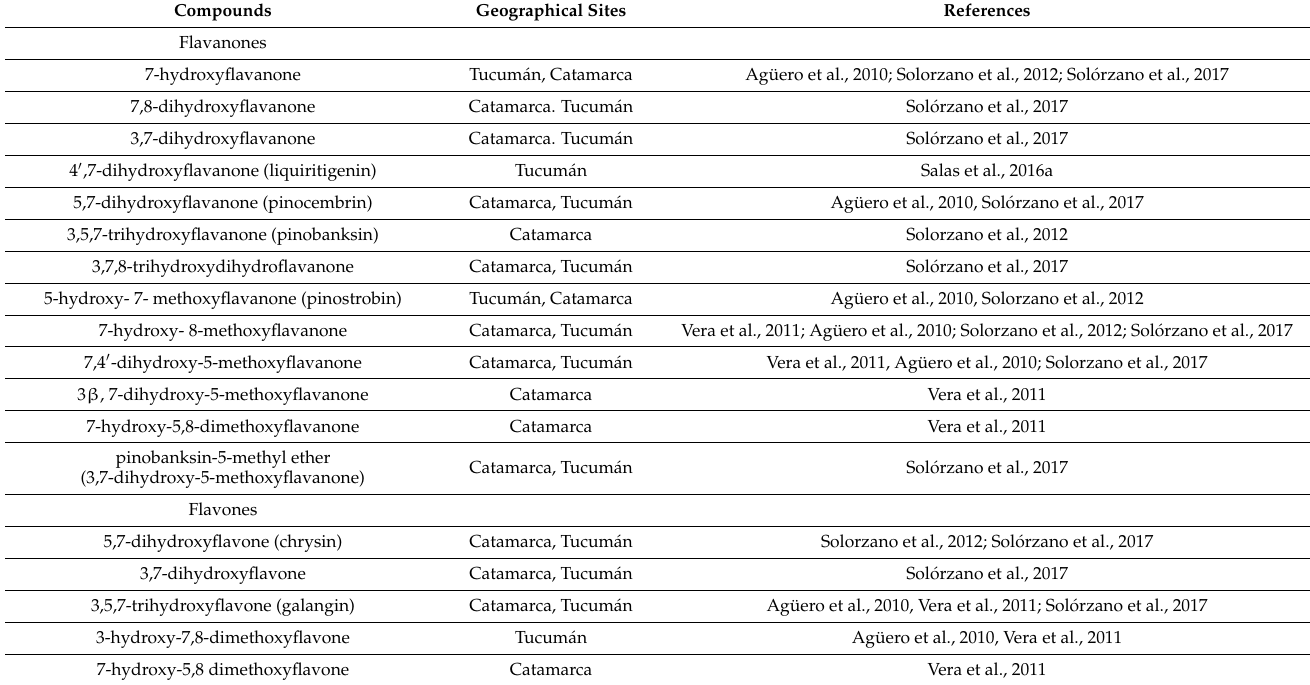
Table 2. Compounds occurring in propolis from the Argentine Monte